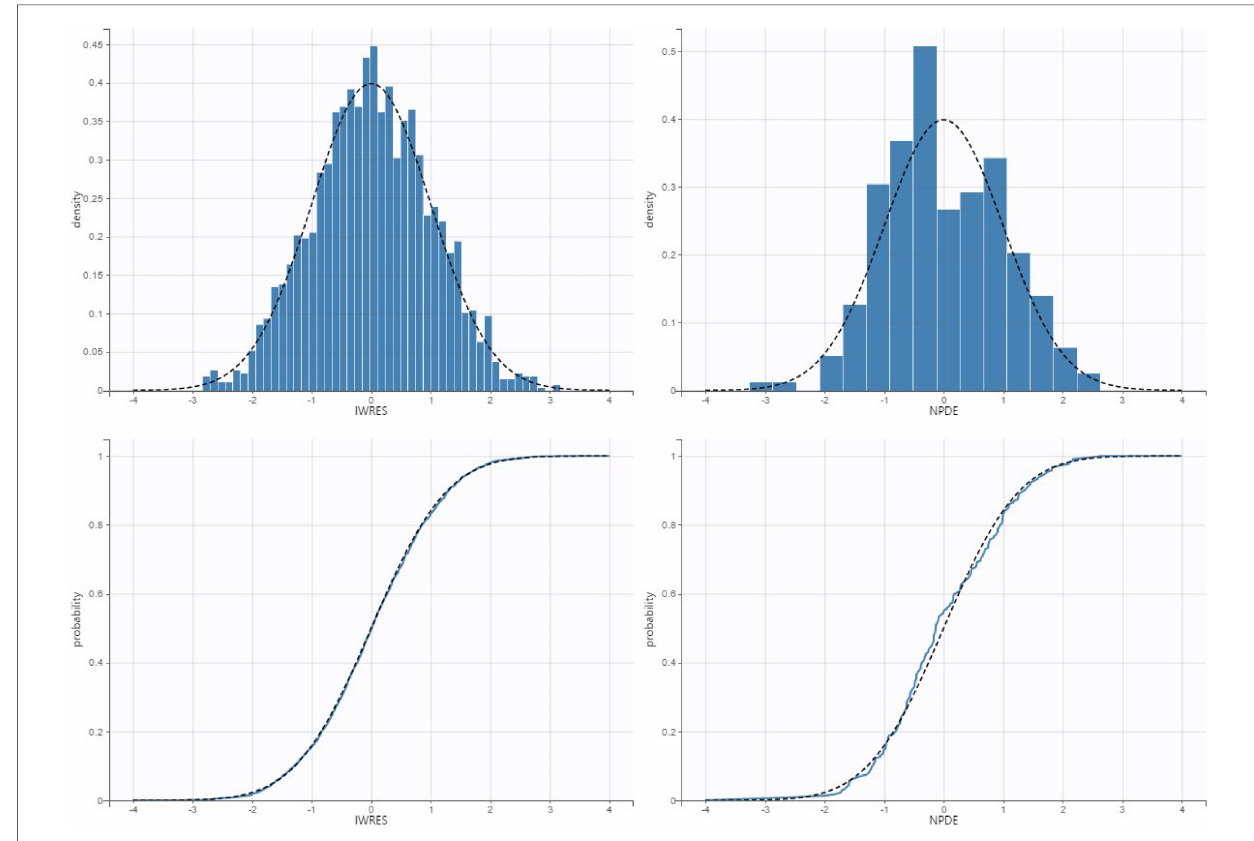
FIGURE 4 Qq plot and histogram of the individual weighed residuals (left) and normalized prediction errors